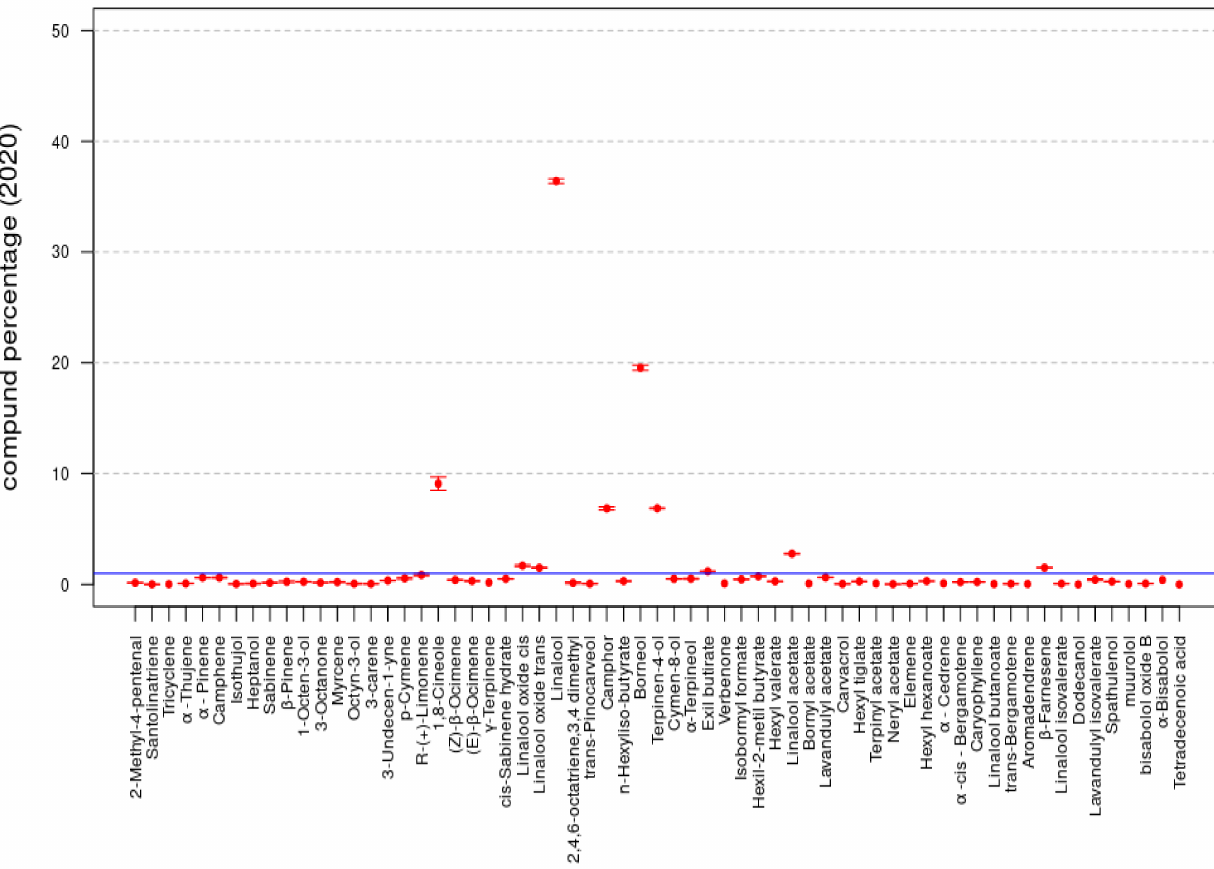
Figure 3. Compound percentages, mean ± SD, LA 2020